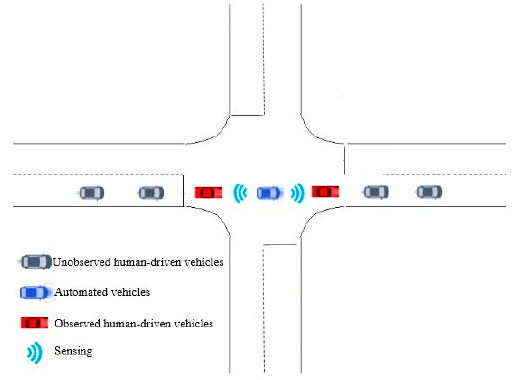
Figure 4. A typical observation space.